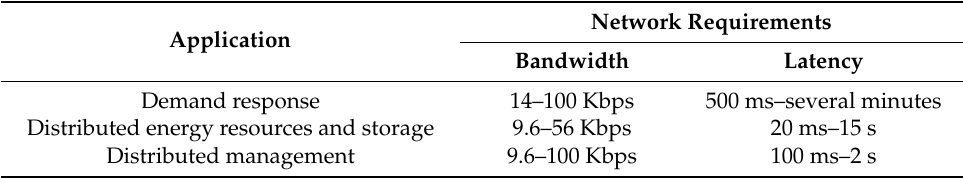
Table 1. MG application and network requirement as stated by IEC 61850 and IEEE 1646